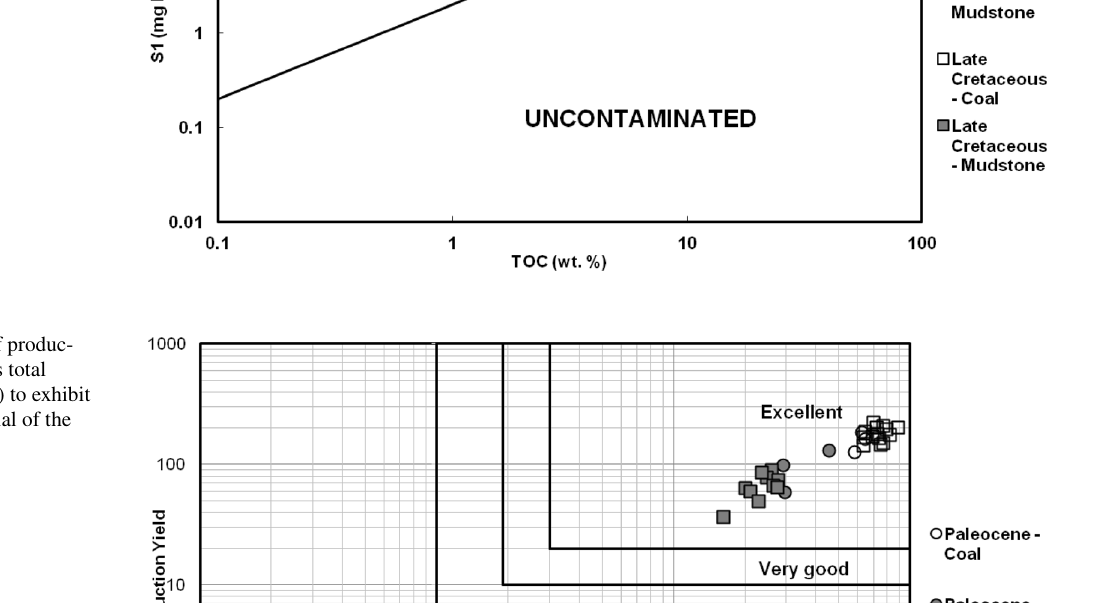
Fig. 3 A cross-plot of S total organic carbon (TOC) to indicate the origin of hydro- carbon in the Taratu Formation (Fakhri et al. 2013)